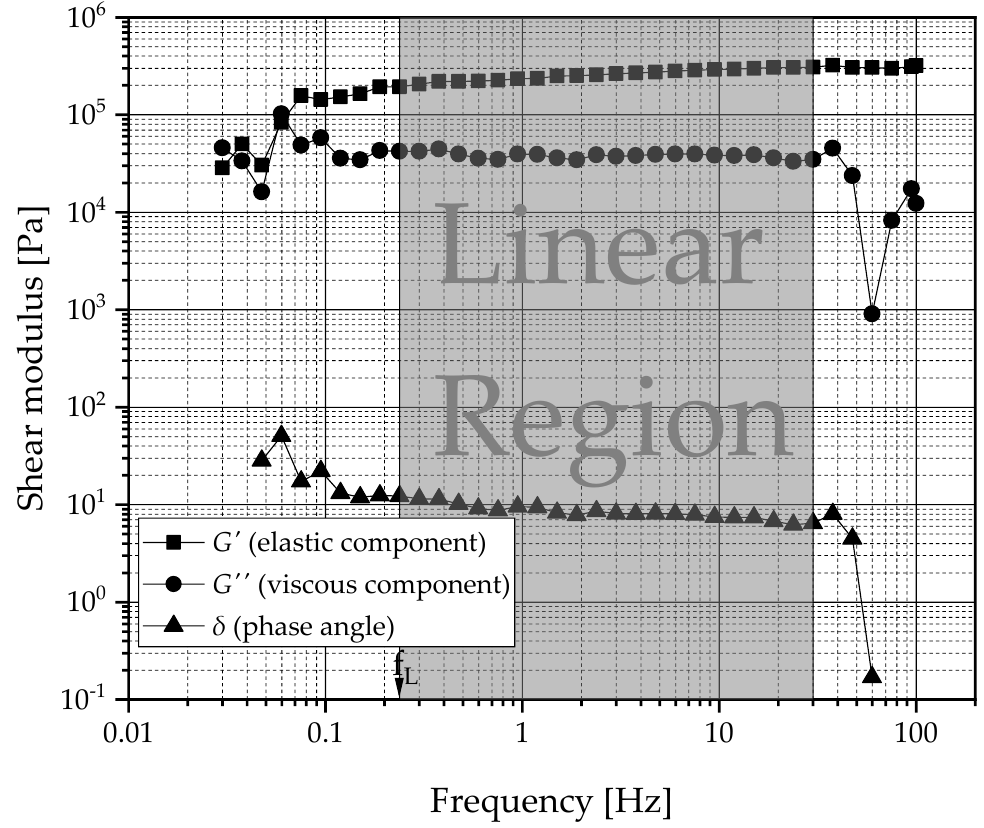
Figure A5. An illustration of an analysis of a frequency sweep. As an example, the frequency sweep of a melted 10-IPM-ISFO is shown, measured at a 0.003% shear strain over frequencies between 0.03 and 100 Hz at 37 °C. The analyzed parameter 𝑓 𝐿 is marked and the linear region is shown as a gray shaded area. To compare the data, the end of the linearity was determined by fitting the G ′ -data using a least-squares linear fit. The frequency of the first data point that exceeds an error of 10% is referred to as the frequency of the linearity limit 𝑓 𝐿 . For emulsions and gels, the tendencies for syneresis can be estimated by the value of the tanδ ; hence, the average of δ in the linearity range was determined and tanδ calculated.